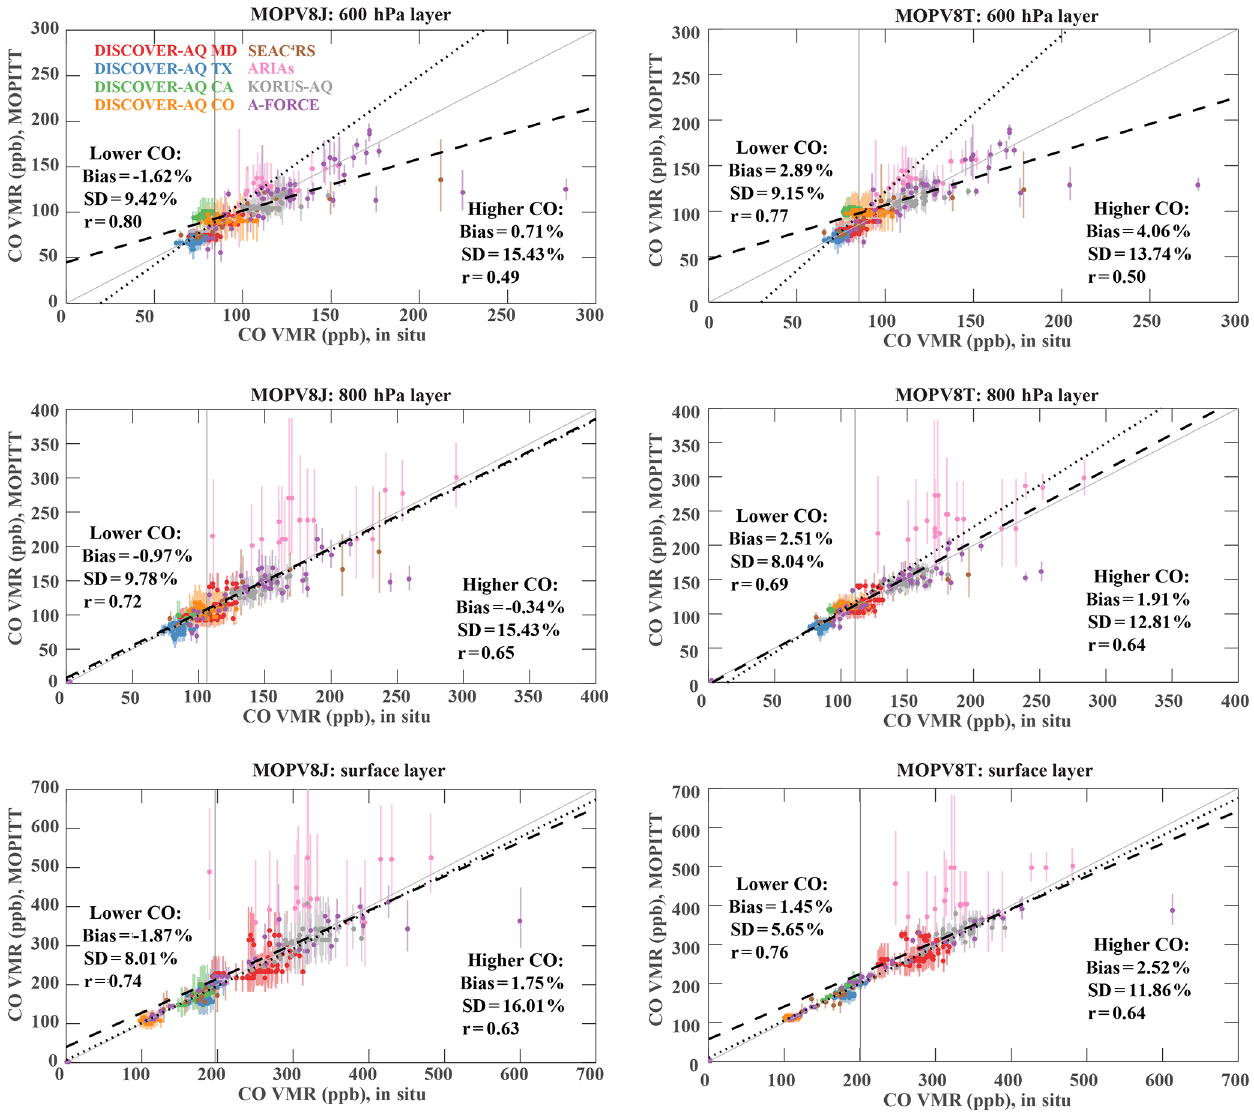
Figure 7. MOPITT V8J and V8T validation results at 600hPa layer, 800hPa layer, and the surface layer against the lower 50% in situ profiles of CO and higher 50% in situ profiles of CO. The variability of the MOPITT data used to calculate each of the plotted mean values is represented by the vertical error bars. Each panel shows the least-squares best-fit lines for the lower 50% CO concentrations (dotted line) and the higher 50% CO concentrations (dashed